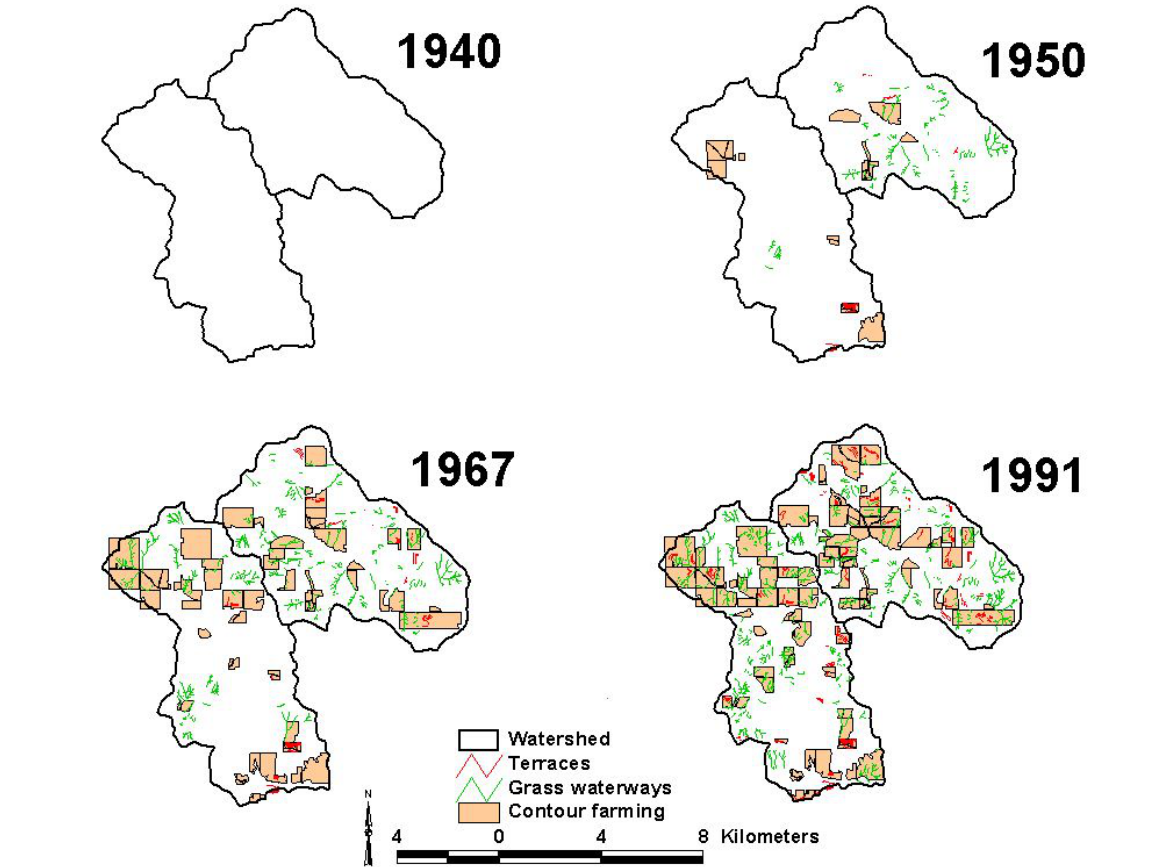
Figure 3. Conservation practice adoption in Walnut Creek (left watershed) and adjacent Squaw Creek (right watershed) from 1940 to 1991. The timing of conservation practice adoption was similar in both